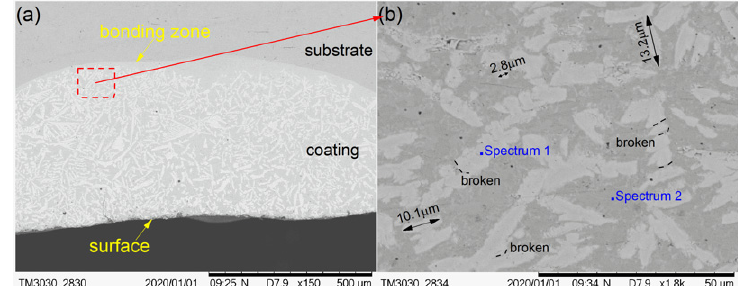
Figure 3. The macro morphology of the coatings: ( a ) 2500 W; ( b ) 2800 W; ( c ) cross section at 2500 W; ( d ) cross section at 2800 W.